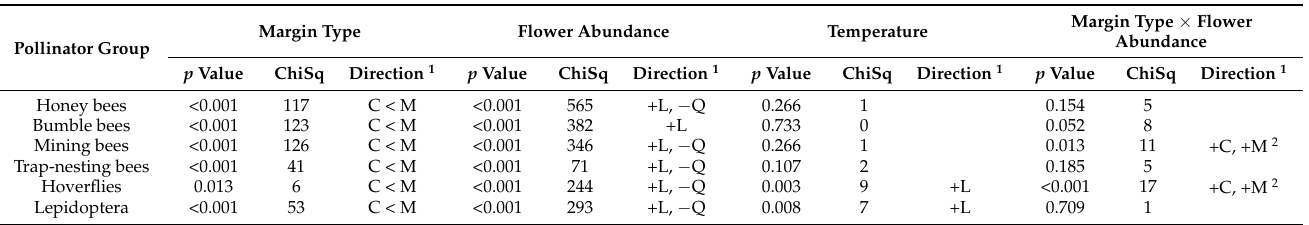
Table 2. The results of the analysis of transect data recording different pollinator groups on control margins and those sown with a flower mix to support pollinators.